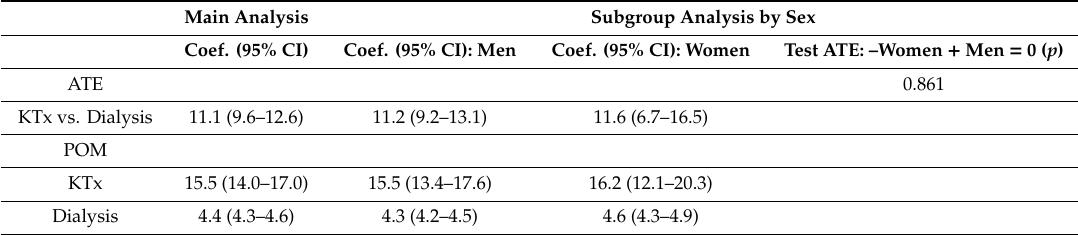
Table 3. Average treatment e ff ect of the treatment on the survival time for patients on the waitlist and subgroup analysis by sex ( n = 2676).